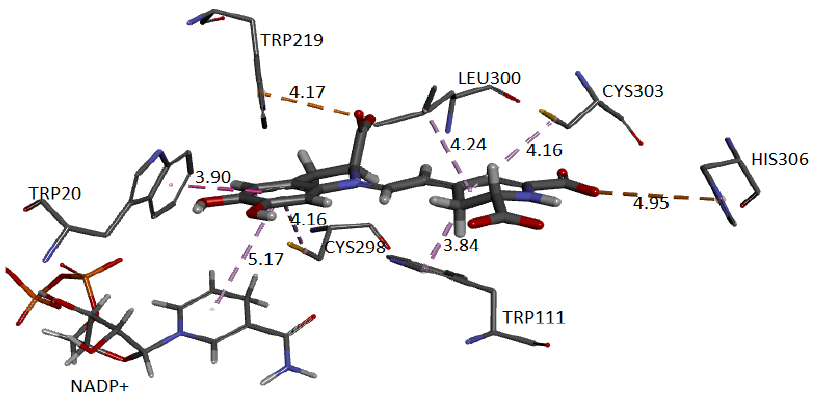
Figure 24. Molecular basis of potential active site interactions with deprotonated Bd (C17C15C2- COOH) via our method.